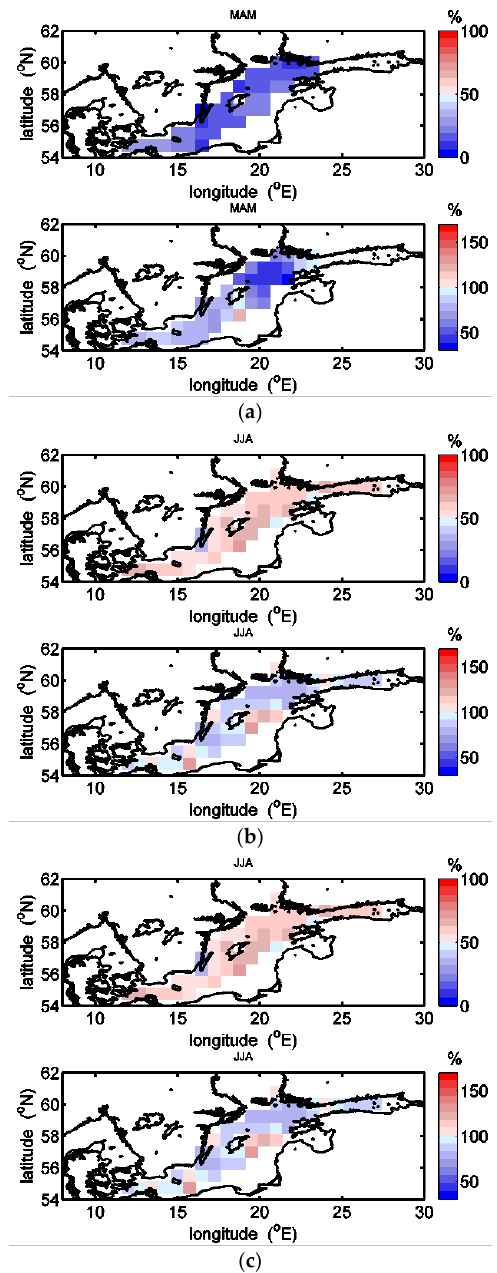
Figure 4. Seasonal estimates of stability and ratios of the ERA-Interim precipitation rate to measured precipitation rate derived from collocated events: ( a ): spring (MAM); ( b ): summer (JJA); and ( c ): autumn (SON). Upper panels gives the frequencies of stable and unstable stratification (0%: none unstable stratification; 50%: in 50% of all cases stratification is unstable; 100%: always unstable stratification), bottom panels show precipitation ratios.